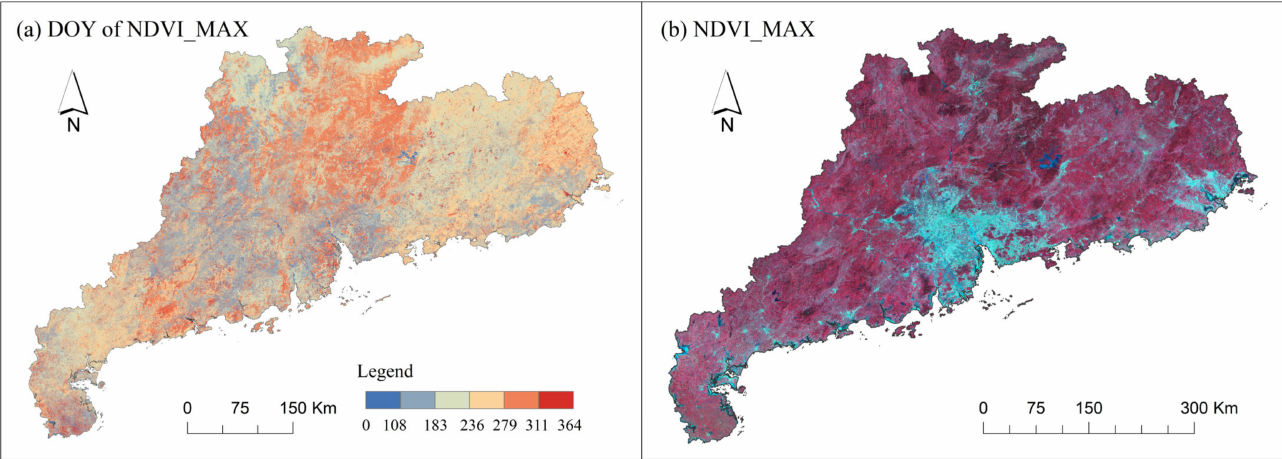
Figure 5. The feature enhancement data (NDVI_MAX) of the study area in 2019. ( a ) shows the Day of Year (DOY) each pixel of NDVI_MAX; ( b ) shows false color image of